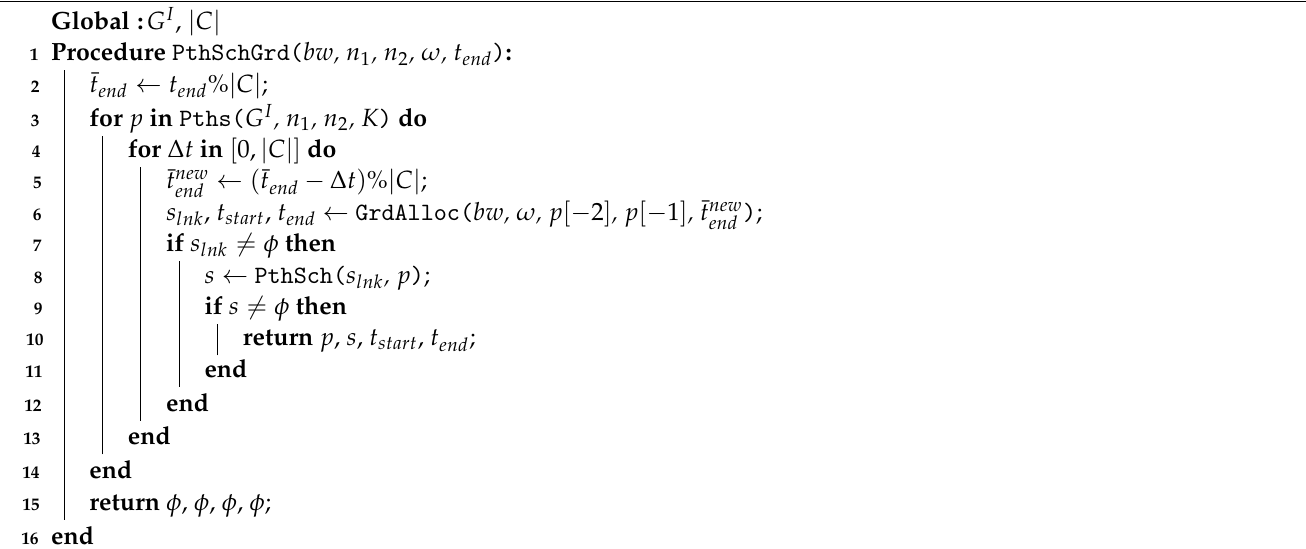
Algorithm 3 Procedure for chaining and scheduling on a path Global : G I , | C